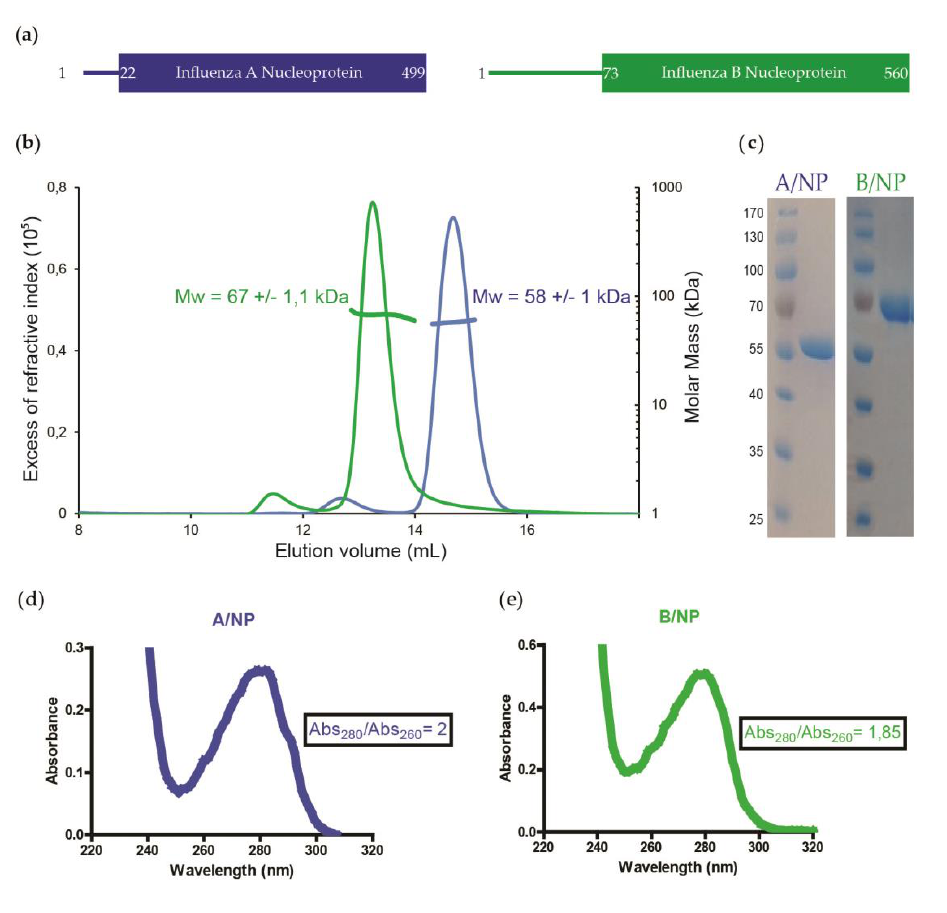
Figure 2. Homogeneous sample analysis of nucleoproteins of influenza A and B viruses. ( a ) Schematic representations of A/NP (blue) and B/NP (green). The A/NP presents a short 21 amino acid N-terminus, whereas B/NP has a longer N-tail of 72 amino acids; ( b ) Comparison of the size exclusion chromatography-multi-angle laser light scattering (SEC-MALLS) analysis of A/NP and B/NP at 50 mM NaCl. Experimental molecular weights, next to the peaks, are coherent with the expected masses of 58 and 65 kDa for A/NP and B/NP, respectively; ( c ) Coomassie blue-stained sodium dodecyl sulfate polyacrylamide gel electrophoresis (SDS-PAGE) gel of the purified A/NP and B/NP; Panels ( d ) and ( e ) are, respectively, the ultraviolet (UV) spectra of the A/NP and B/NP. Mw: molecular weight; Abs: